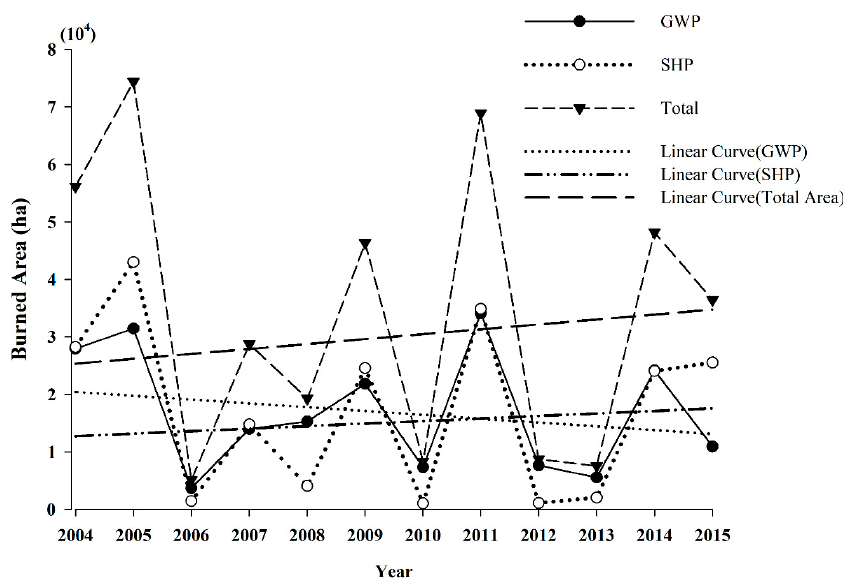
Figure 5. Burned areas (MODIS) in the study regions from 2004 to 2015.